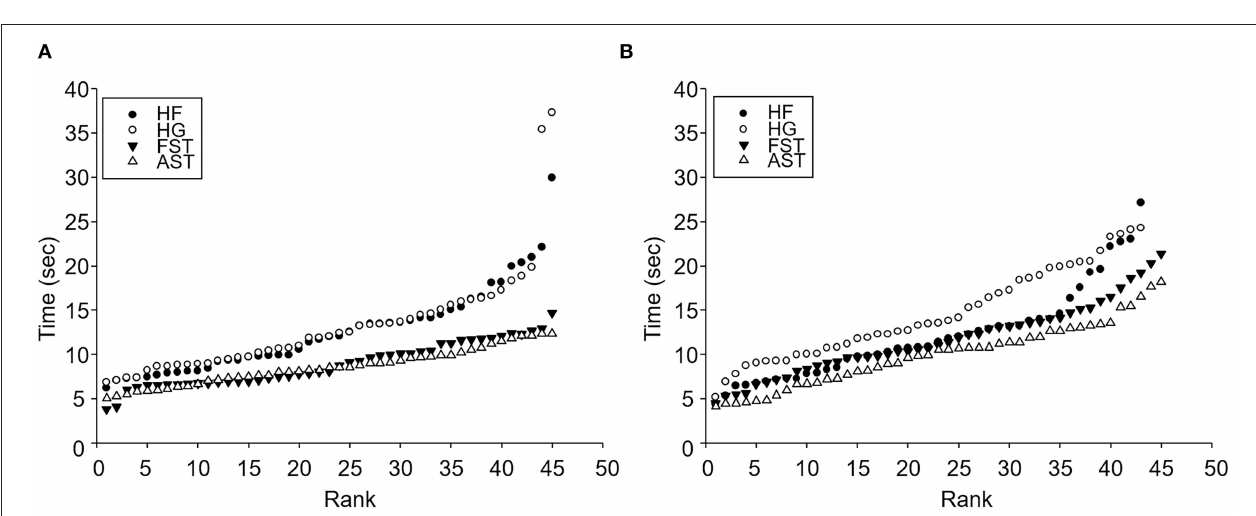
FIGURE 3 | Rank distribution of movement activities of 2 hybrids and conspecific colonies. (A) Passing time and (B) Stop time. Black circles, blank circles, black triangles, and blank triangles are HF, HG, FST, and AST. HF ( ♀ AST × ♂ FST), HG ( ♀ FST × ♂ AST), FST ( ♀ FST × ♂ FST), and AST ( ♀ AST × ♂ AST). FST, Formosan subterranean termites; Coptotermes formosanus Shiraki; AST, Asian subterranean termites; C. gestroi (Wasmann).